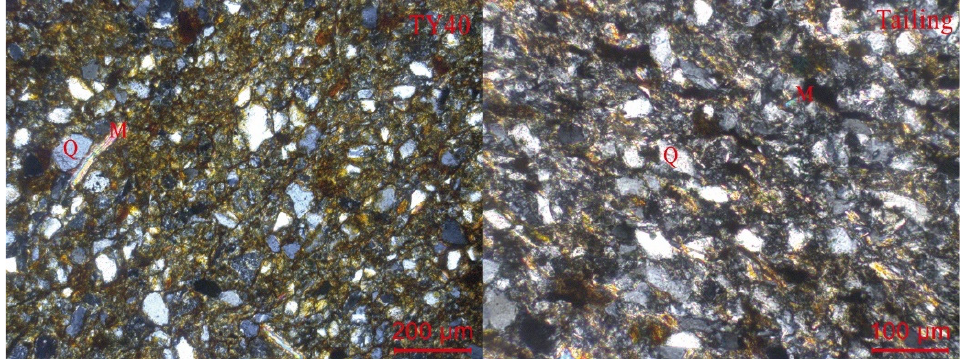
Figure 3. Surface morphology of the soil (TY40) and tailing under microscope. M—muscovite; Q—quartz.